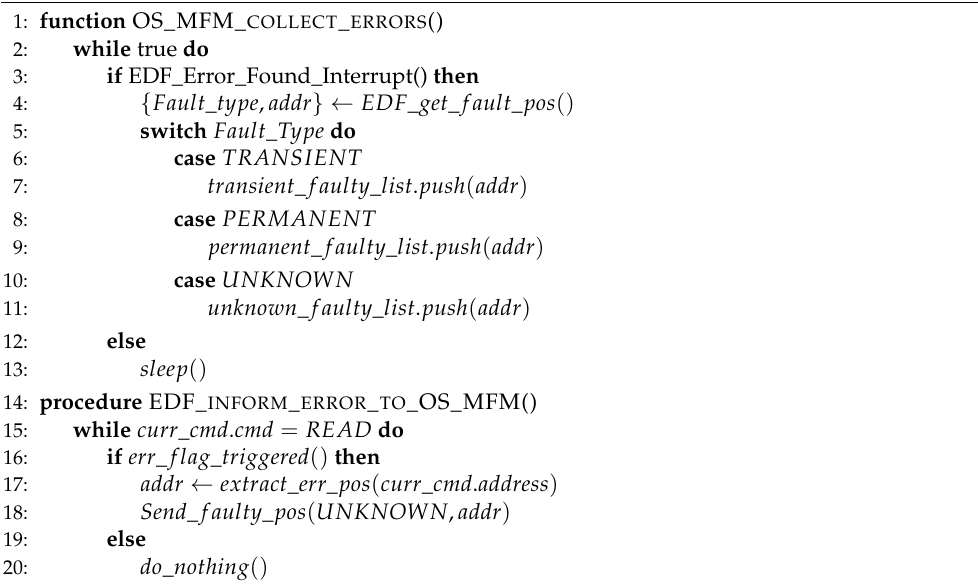
Algorithm 1 Collecting the error position from EDF to